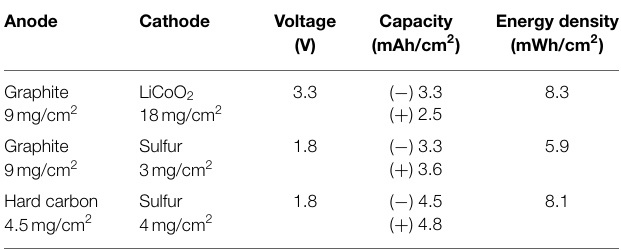
TABLE 1 | Possible combination of conventional anodes and sulfur-based cathodes